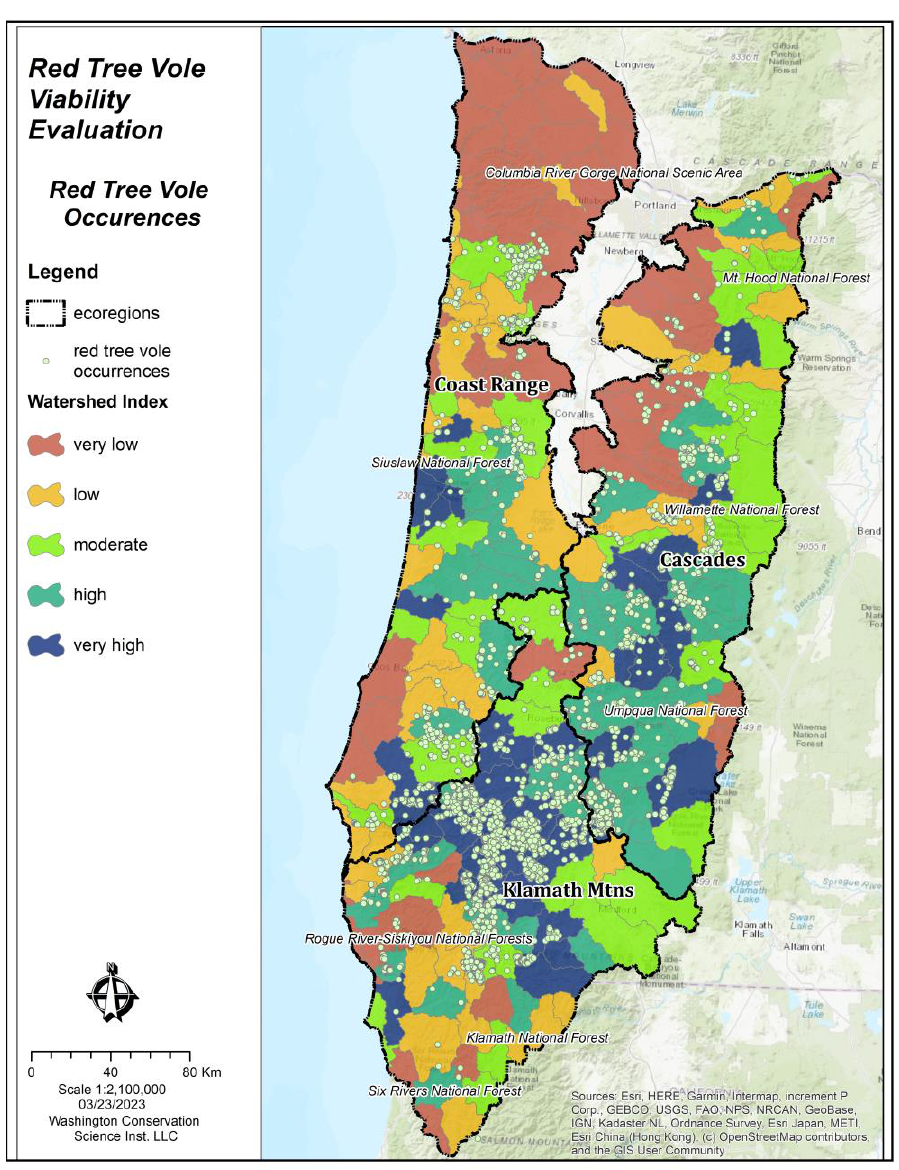
Figure 7. Red tree vole ( Arborimus longicaudus ) occurrences and watershed index values across ecoregions in the evaluation areas of Oregon and California, USA.